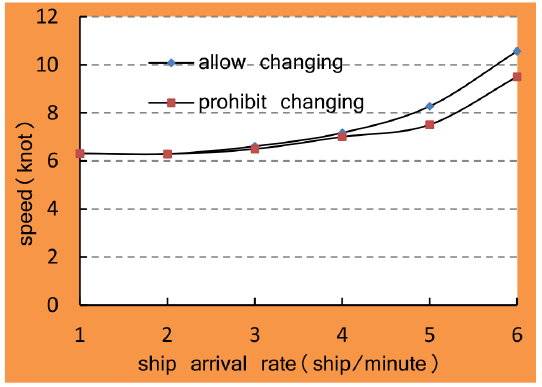
Figure 9. Average speed and ship arrival rate as a function when inbound and outbound ship arrival rates are